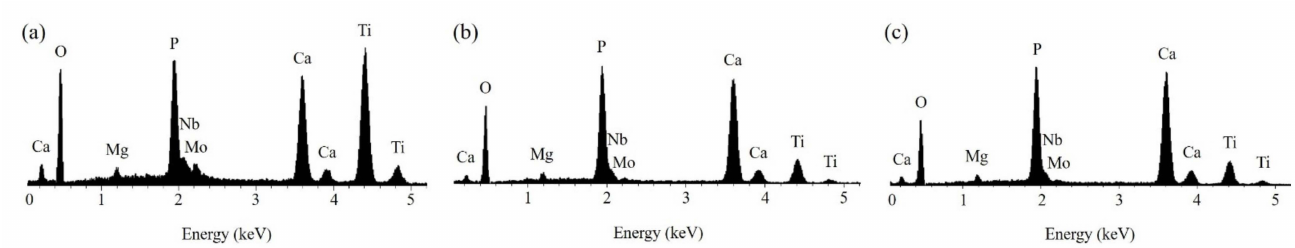
Figure 6. EDS results (mapping mode) of anodized Ti–5Nb–5Mo under hydrothermal or vapor thermal treatments at 150 ◦ C for 6 h after soaking in SBF for 7 days: ( a ) as-anodized, ( b ) H150t6, and ( c ) V150t6.